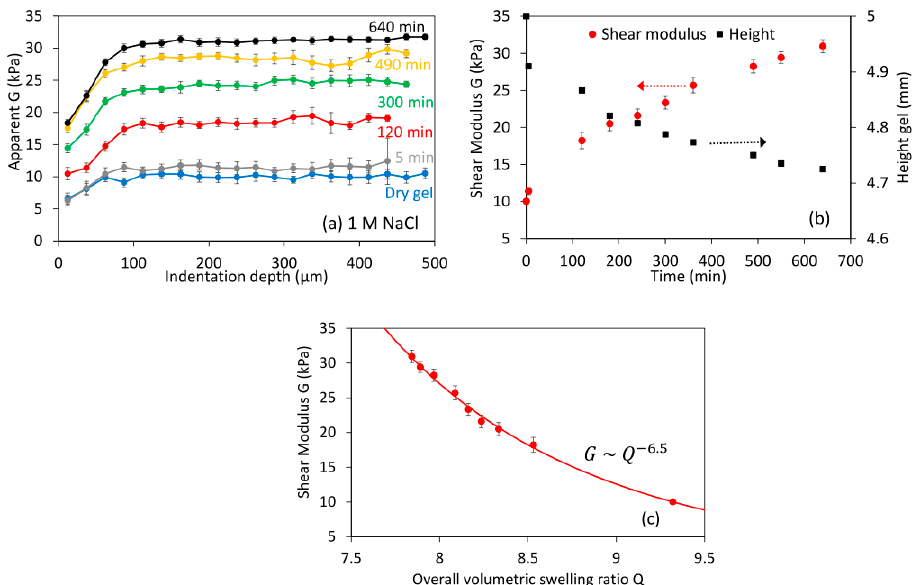
Figure 6. Swelling at neutral pH and at 1 M NaCl. ( a ) Shear modulus with the indentation depth at different swelling times; ( b ) average modulus (>50 µ m indentation depth) and estimated gel height at different swelling times; ( c ) correlation between the shear modulus and the overall volumetric swelling ratio Q; the continuous line is the best power law fit. Error bars in ( a ) as in Figure 4, in ( b , c ) as in Figure 5.